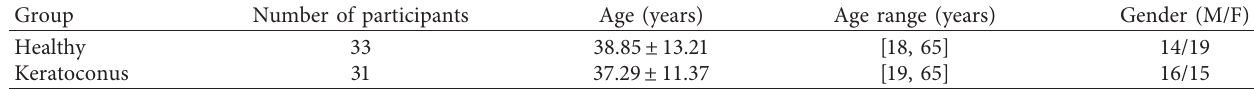
Table 1: Demographic characteristics of the participants in the study.